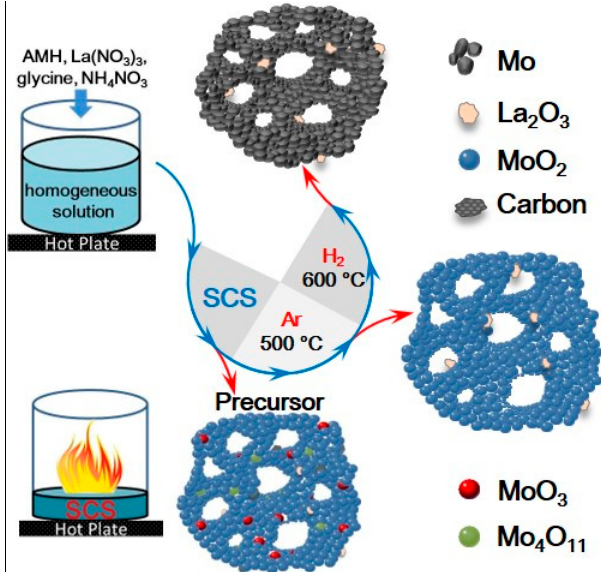
Figure 2. Schematic diagram describing the preparation of La 2 O 3 uniformly doped Mo nanopowders via the SCSHR route.